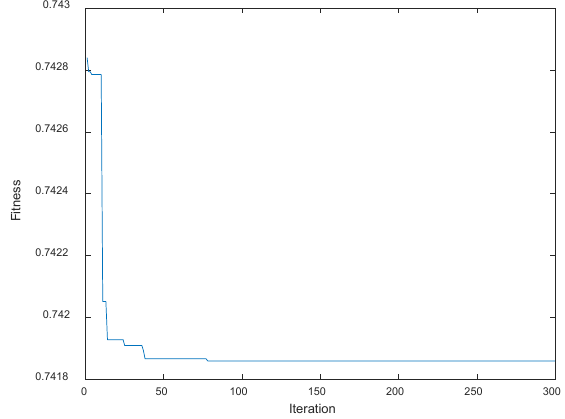
Figure 6. Fitness curve (PSO).